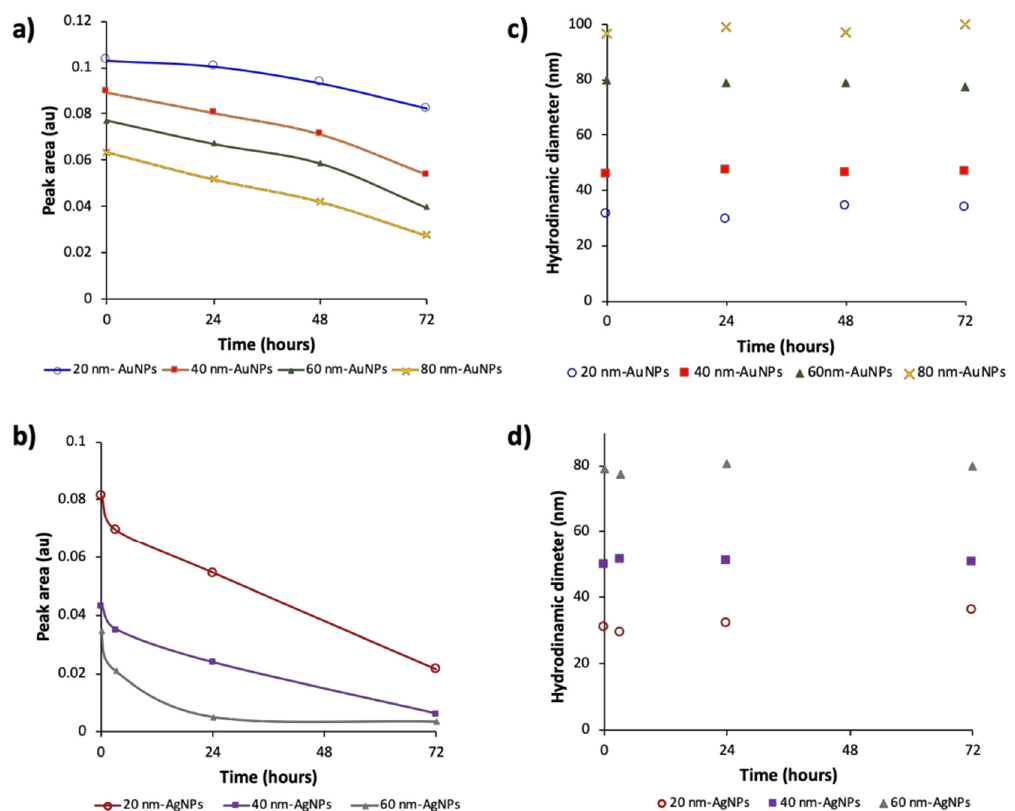
Figure 4. ( a ) Variation of the peak area as a function of time for citrate-capped-AuNPs. ( b ) Variation of the hydrodynamic diameter as a function of time for citrate-capped-AuNPs. ( c ) Variation of the peak area as a function of time for citrate-capped-AgNPs and, ( d ) Variation of the hydrodynamic diameter as a function of time for citrate-capped AgNPs.